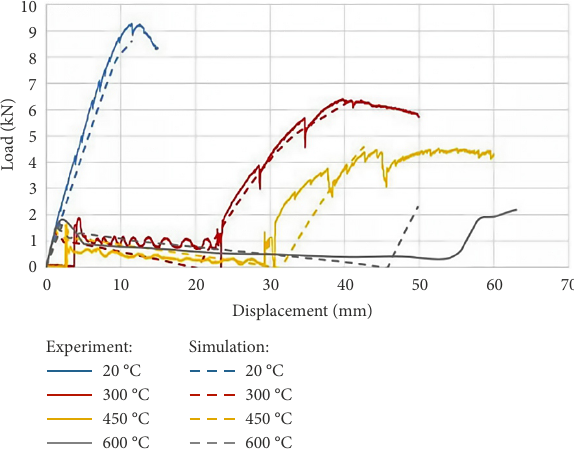
Figure 5. Load-displacement curves for MW panels 100 mm